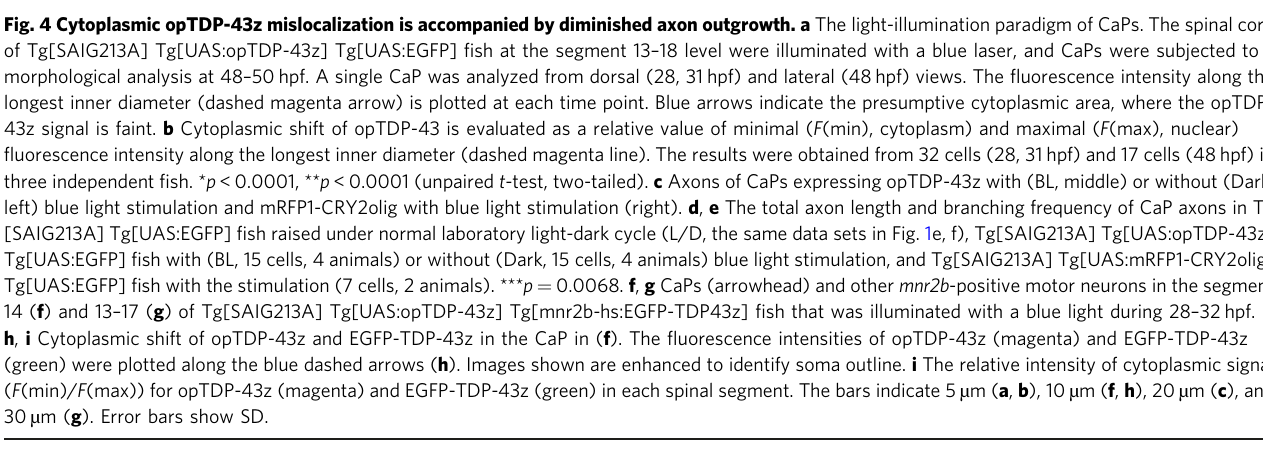
Fig. 4 Cytoplasmic opTDP-43z mislocalization is accompanied by diminished axon outgrowth. a The light-illumination paradigm of CaPs. The spinal cord of Tg[SAIG213A] Tg[UAS:opTDP-43z] Tg[UAS:EGFP] fi sh at the segment 13 – 18 level were illuminated with a blue laser, and CaPs were subjected to morphological analysis at 48 – 50 hpf. A single CaP was analyzed from dorsal (28, 31 hpf) and lateral (48 hpf) views. The fl uorescence intensity along the longest inner diameter (dashed magenta arrow) is plotted at each time point. Blue arrows indicate the presumptive cytoplasmic area, where the opTDP- 43z signal is faint. b Cytoplasmic shift of opTDP-43 is evaluated as a relative value of minimal ( F (min), cytoplasm) and maximal ( F (max), nuclear) fl uorescence intensity along the longest inner diameter (dashed magenta line). The results were obtained from 32 cells (28, 31 hpf) and 17 cells (48 hpf) in three independent fi sh. * p < 0.0001, ** p < 0.0001 (unpaired t -test, two-tailed). c Axons of CaPs expressing opTDP-43z with (BL, middle) or without (Dark, left) blue light stimulation and mRFP1-CRY2olig with blue light stimulation (right). d , e The total axon length and branching frequency of CaP axons in Tg [SAIG213A] Tg[UAS:EGFP] fi sh raised under normal laboratory light-dark cycle (L/D, the same data sets in Fig. 1e, f), Tg[SAIG213A] Tg[UAS:opTDP-43z] Tg[UAS:EGFP] fi sh with (BL, 15 cells, 4 animals) or without (Dark, 15 cells, 4 animals) blue light stimulation, and Tg[SAIG213A] Tg[UAS:mRFP1-CRY2olig] Tg[UAS:EGFP] fi sh with the stimulation (7 cells, 2 animals). *** p = 0.0068. f , g CaPs (arrowhead) and other mnr2b -positive motor neurons in the segment 14 ( f ) and 13 – 17 ( g ) of Tg[SAIG213A] Tg[UAS:opTDP-43z] Tg[mnr2b-hs:EGFP-TDP43z] fi sh that was illuminated with a blue light during 28 – 32 hpf. h , i Cytoplasmic shift of opTDP-43z and EGFP-TDP-43z in the CaP in ( f ). The fl uorescence intensities of opTDP-43z (magenta) and EGFP-TDP-43z (green) were plotted along the blue dashed arrows ( h ). Images shown are enhanced to identify soma outline. i The relative intensity of cytoplasmic signal ( F (min)/ F (max)) for opTDP-43z (magenta) and EGFP-TDP-43z (green) in each spinal segment. The bars indicate 5 µ m ( a , b ), 10 µ m ( f , h ), 20 µ m ( c ), and 30 µ m ( g ). Error bars